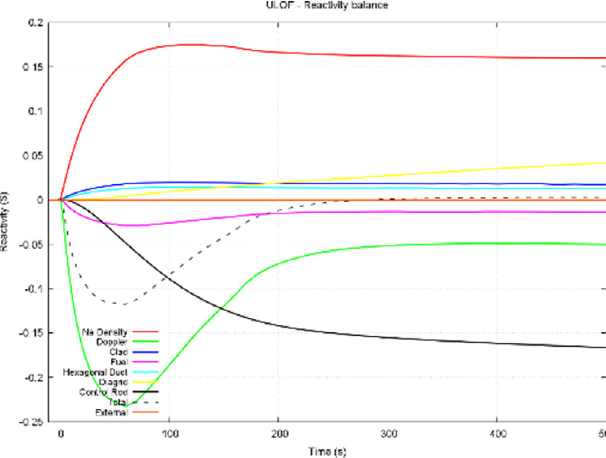
Fig. 9. Reactivity balance.